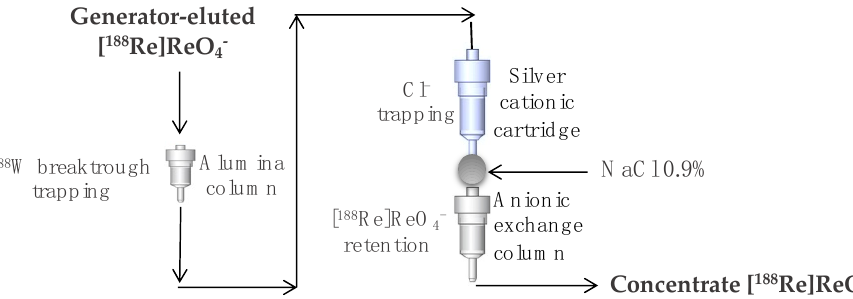
Figure 4. 188 Re post-elution concentration system.